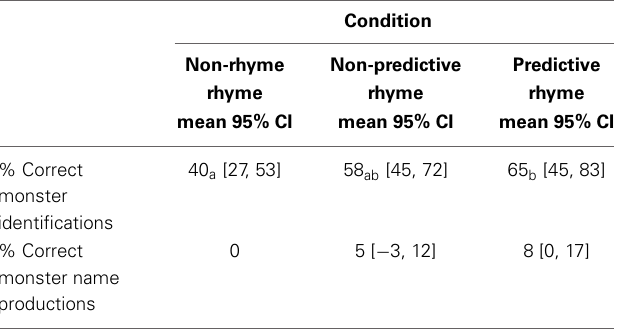
Table 2 | Response performance by Condition in Experiment